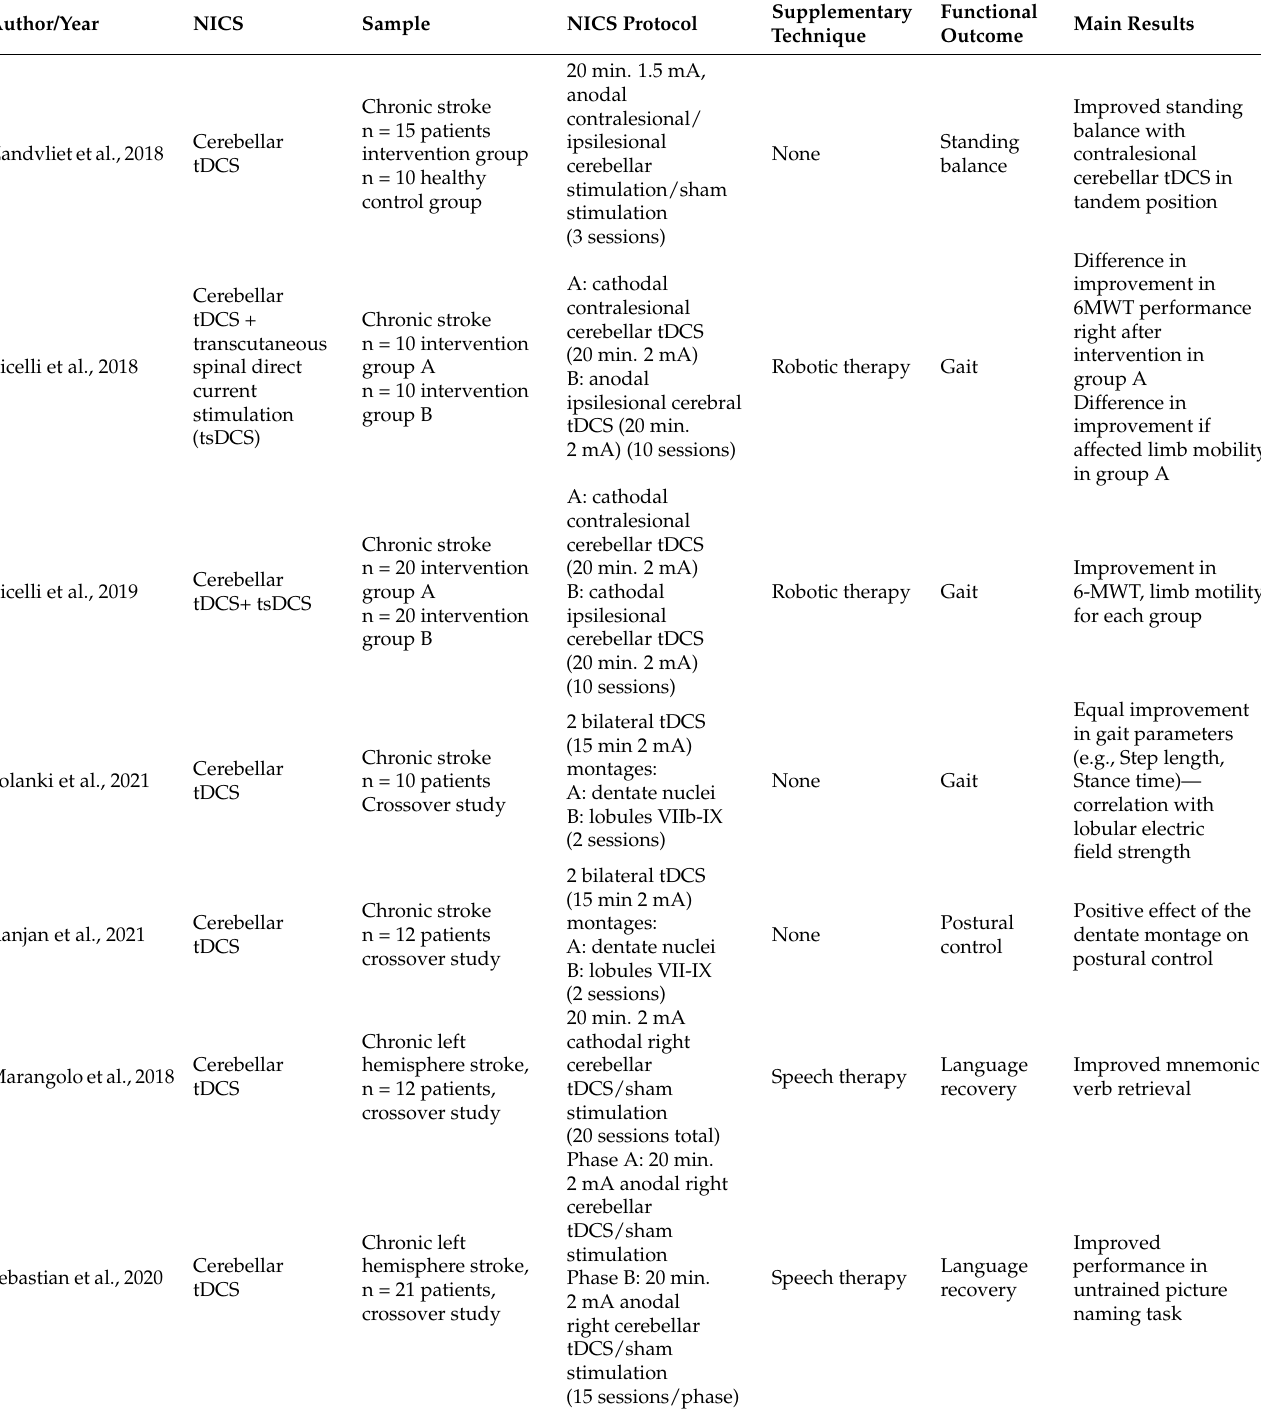
Table 2. Clinical studies concerning cerebellar tDCS applications in stroke